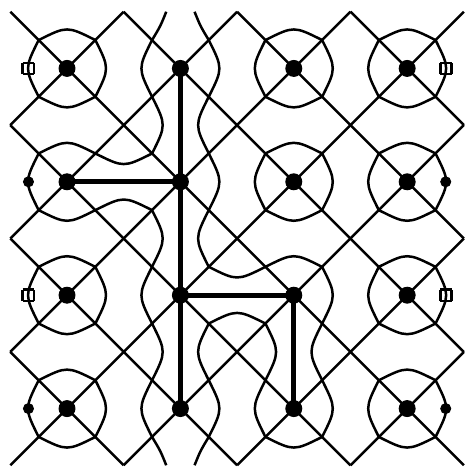
Figure 15 . Alt on both sides: correlated boundary conditions in the bu sector with j = 1.